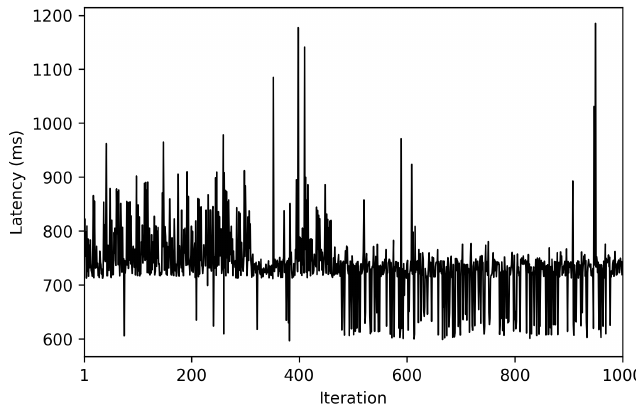
Figure 21. End-to-end latency for 1000 data